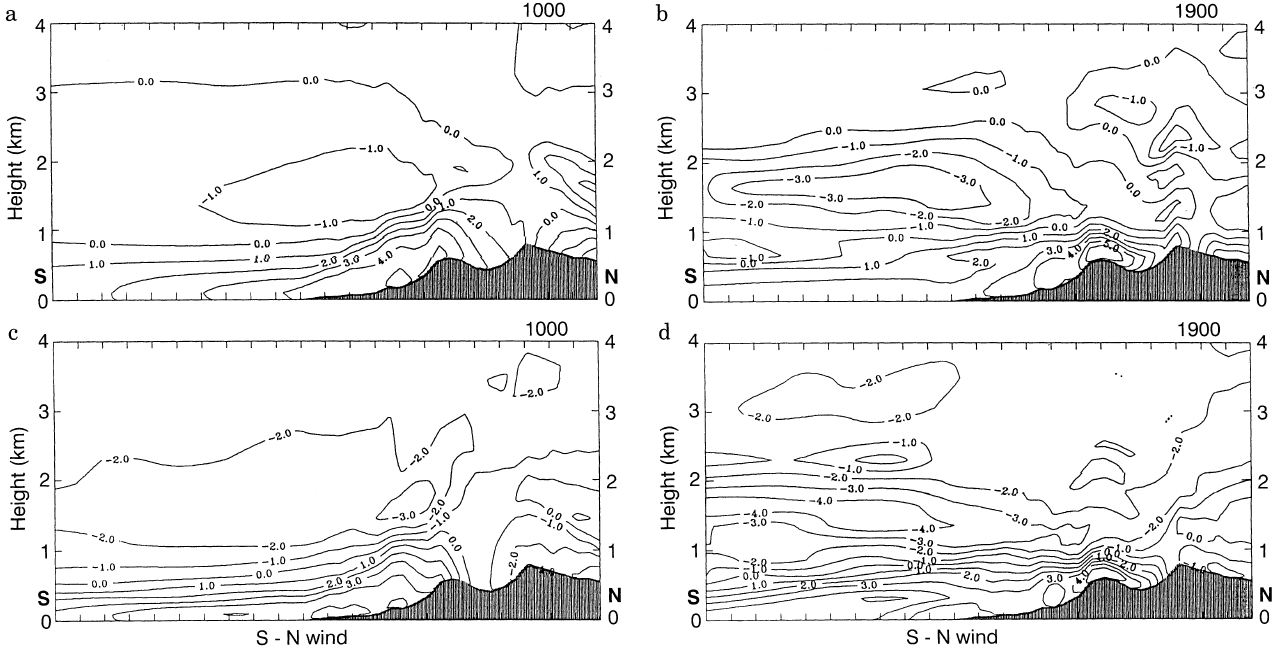
Fig. 3a–d. Vertical cross sections of S-N wind component in m/s at a 1000 LST, E1; b 1900 LST, E1; c 1000 LST, E2; d 1900 LST,